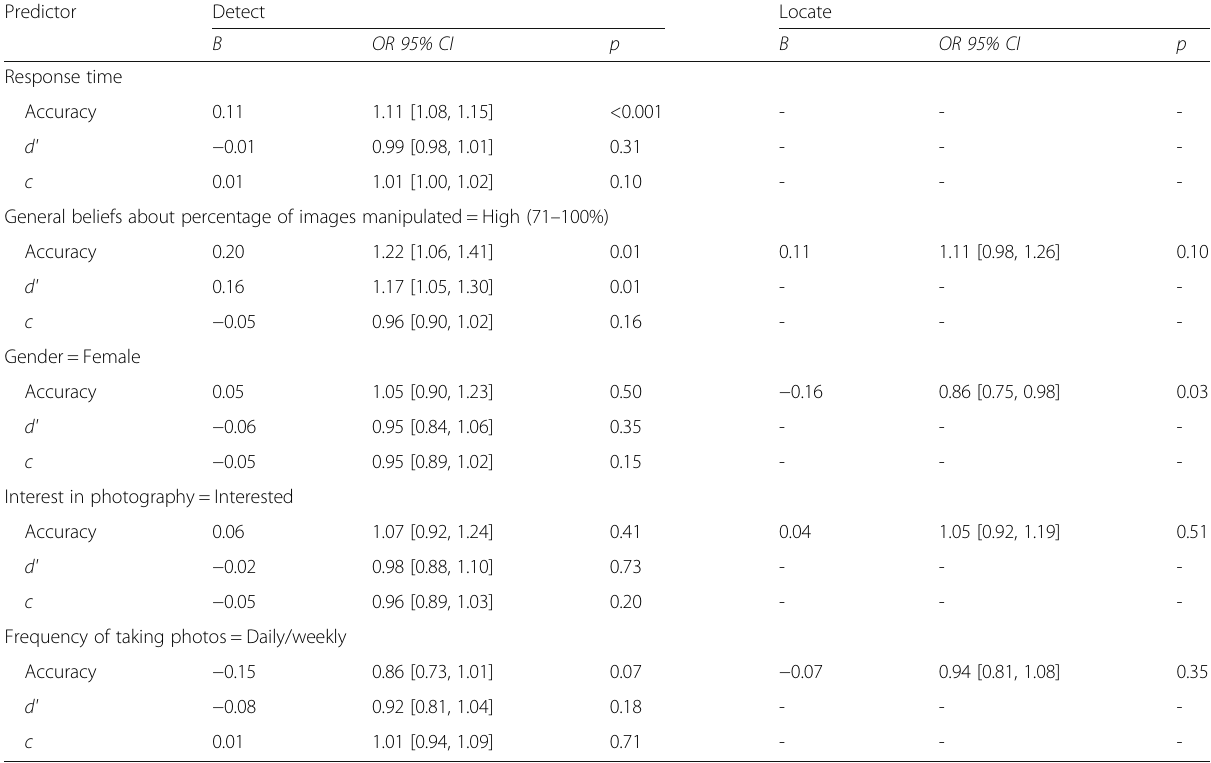
Table 2 Results of the GEE binary logistic and linear regression models to determine variables that predict accuracy on the detect and locate tasks Predictor